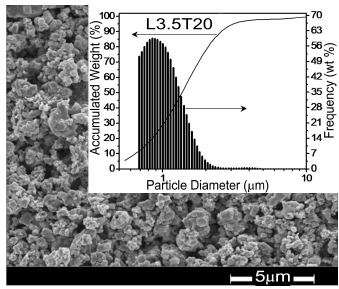
Figure 2. SEM micrograph of the powder with composition L3.5T20. The inset shows the particle size distribution for this powder.